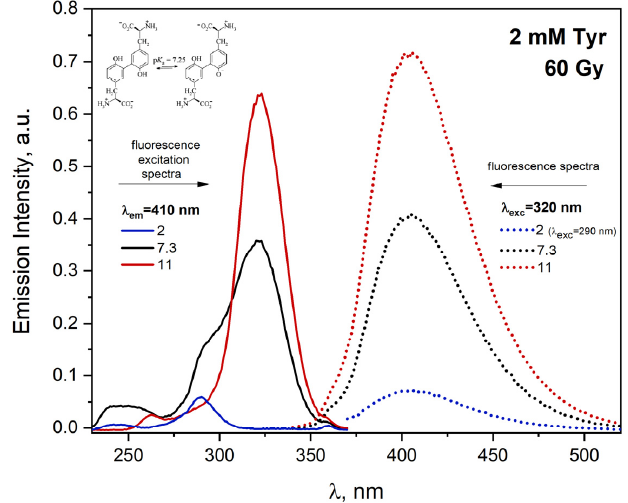
Figure 12. Emission spectra of the N 2 O-saturated Tyr solutions (2 mM) under pH: 2, 7.3 and 11, recorded after irradiation with a dose 60 Gy. The excitation wavelength was 320 nm. Emission excitation spectra of the N 2 O-saturated Tyr solutions (2 mM) under pH: 2, 7.3 and 11, recorded before and after irradiation with a dose 60 Gy. The emission wavelength was 410 nm.